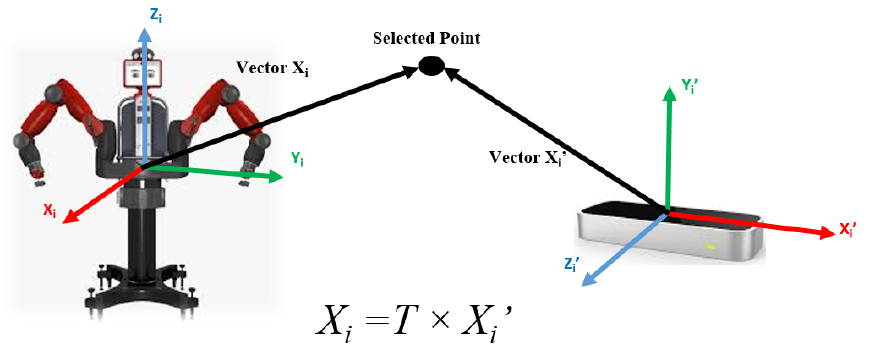
Figure 5. Illustration of the relationship between Baxter Robot and LeapMotion coordinate